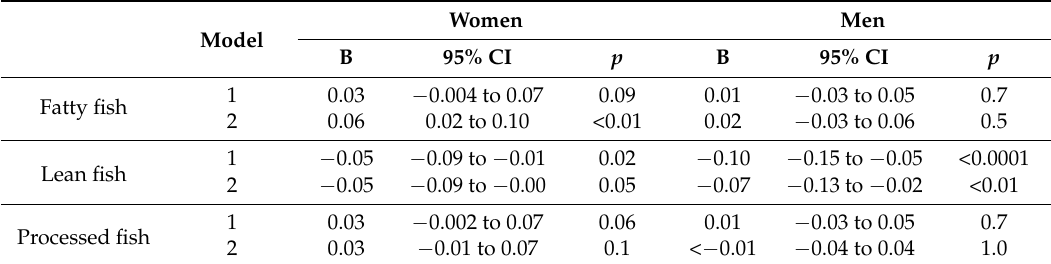
Table 5. Estimated change in metabolic score by consumption